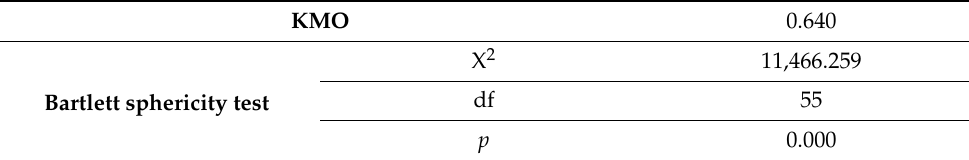
Table 2. KMO and Bartlett sphericity test.